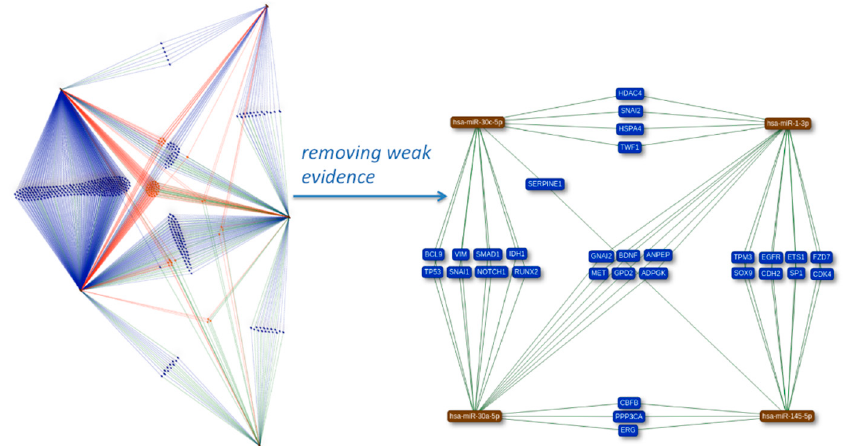
Figure 2. Multi-miRNA mode. For five cardio miRNAs, the network of genes that are targeted by at least two miRNAs (experimental evidence) is shown. Edge color indicates the number of miRNA-target interactions for the miRNAs that are start nodes of the edges. The second representation highlights the genes that are supported by strong evidence experiments.